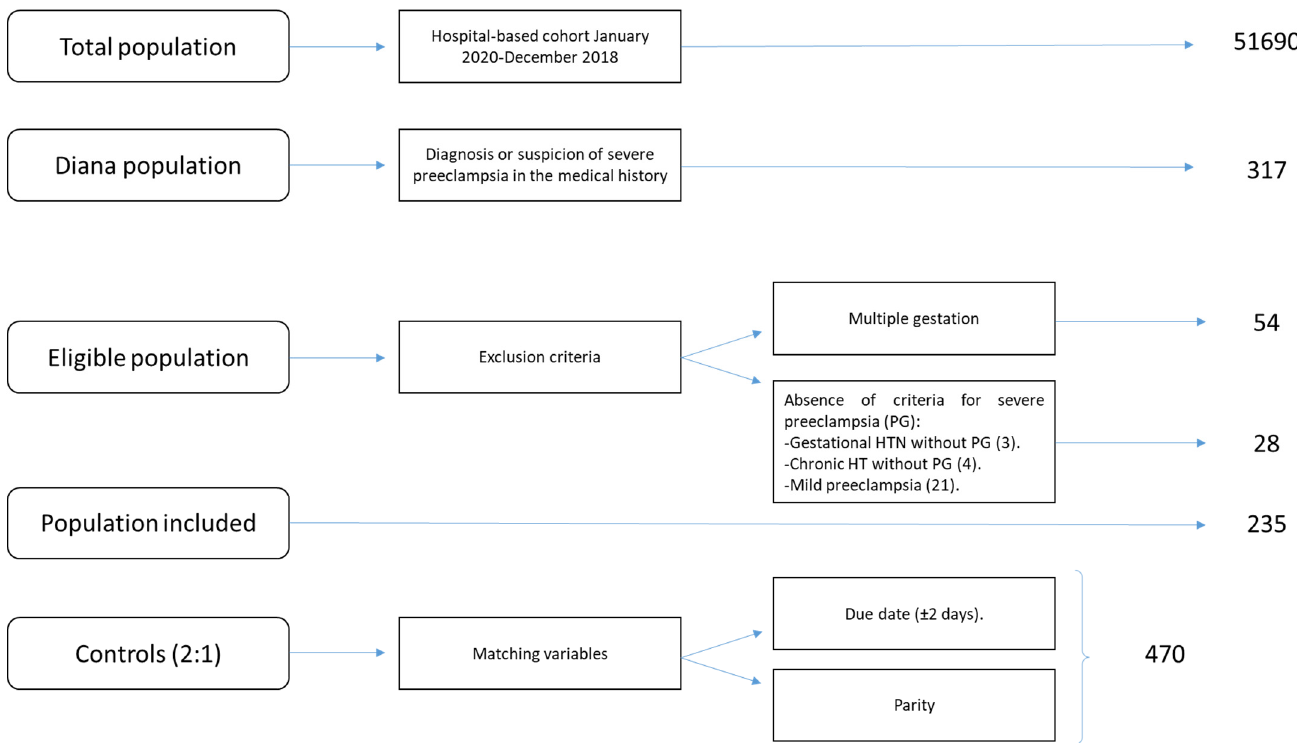
Figure 1. Flowchart of the nested case-control study in a hospital-based cohort.